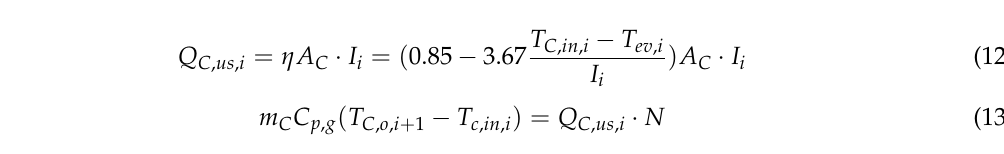
Figure 8. Operation model of the solar collector that supplies heat to the phase-change thermal storage tank.